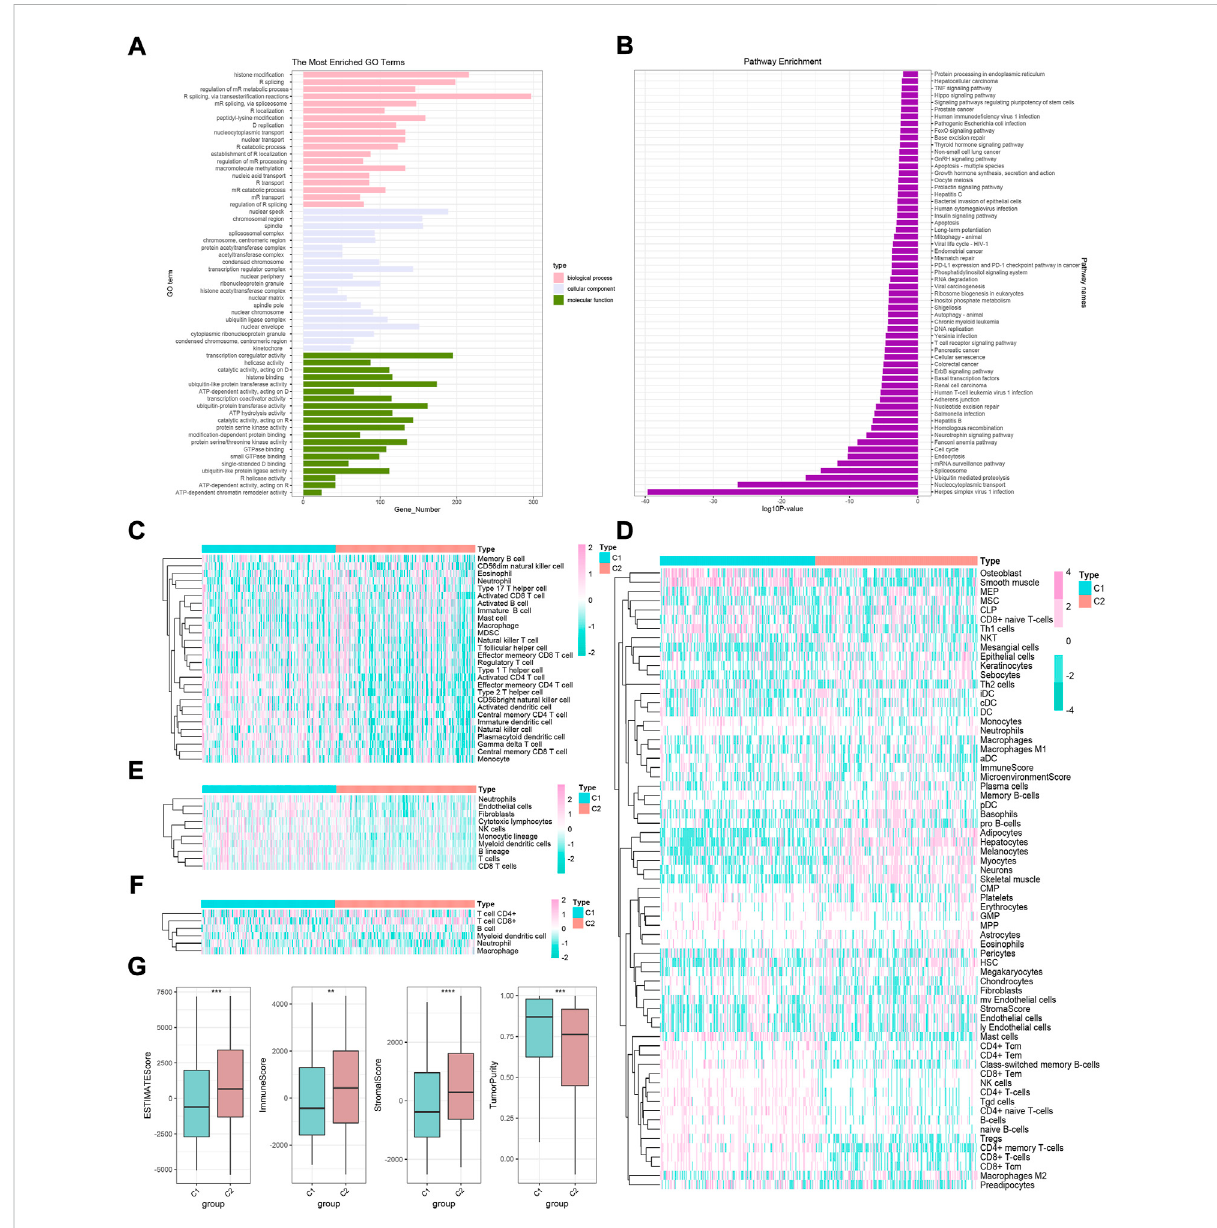
FIGURE 2 GO and KEGG analyses and immune cell in fi ltration characteristics in two m6A modi fi cation modes in HCC. (A) GO enrichment analysis. (B) KEGG enrichment analysis. (C – F) Heatmaps of immune cell in fi ltration in m6A modi fi cation patterns based on ssGSEA, xCell, MCP-counter, and TIMERalgorithms,respectively. (G) DifferenceinESTIMATE,immune,stromal,andtumorpurityscoresbetweentwom6Amodi fi cationmodesbased on ESTIMATE